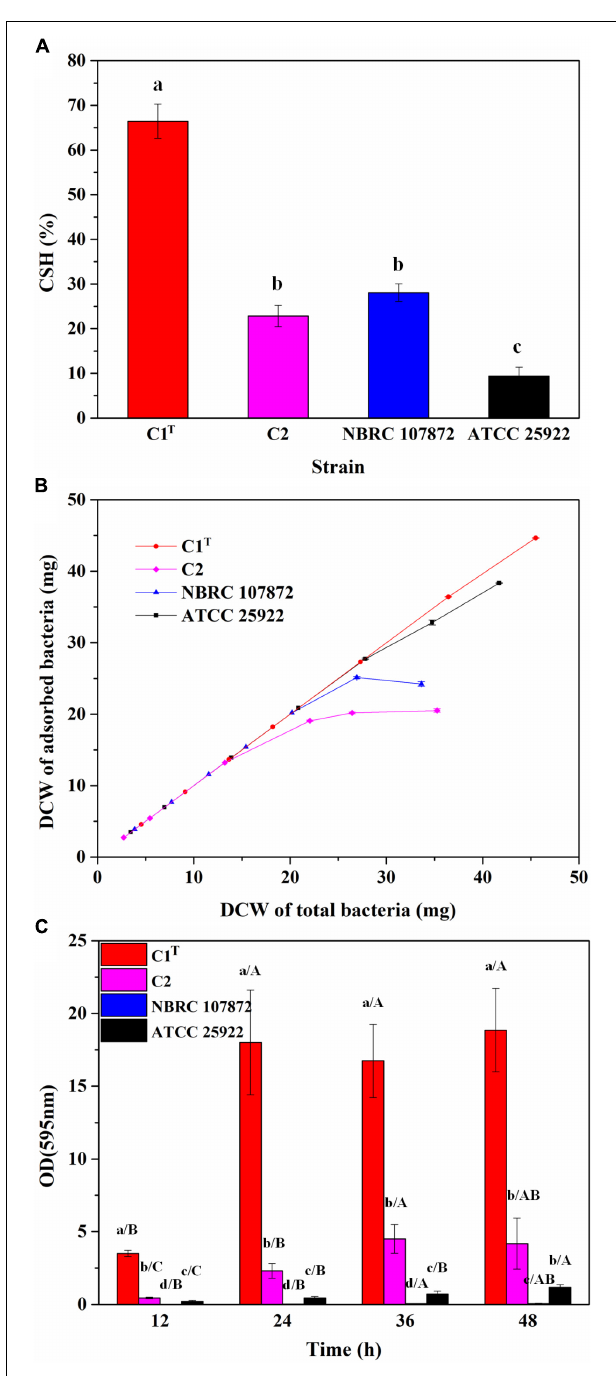
FIGURE 2 | The colonization ability of strains C1 T , C2, NBRC 107872 and ATCC 25922. (A) Cell surface hydrophobicity (CSH) measured by MATH protocol. The values are means of triplicate investigations, and error bars indicate standard deviations. Significant differences were tested by one-way ANOVA with Bonferroni test ( n = 3, α = 0.05). The a, b and c represent the differences among these strains. (B) The adhesion capacity to kaolinite. Experiments were conducted with a fixed amount of kaolinite (4 g/L) and varying amounts of bacteria in 30 mL of 1 mM KNO 3 . The values are means of triplicate investigations, and error bars indicate standard deviations. DCW,